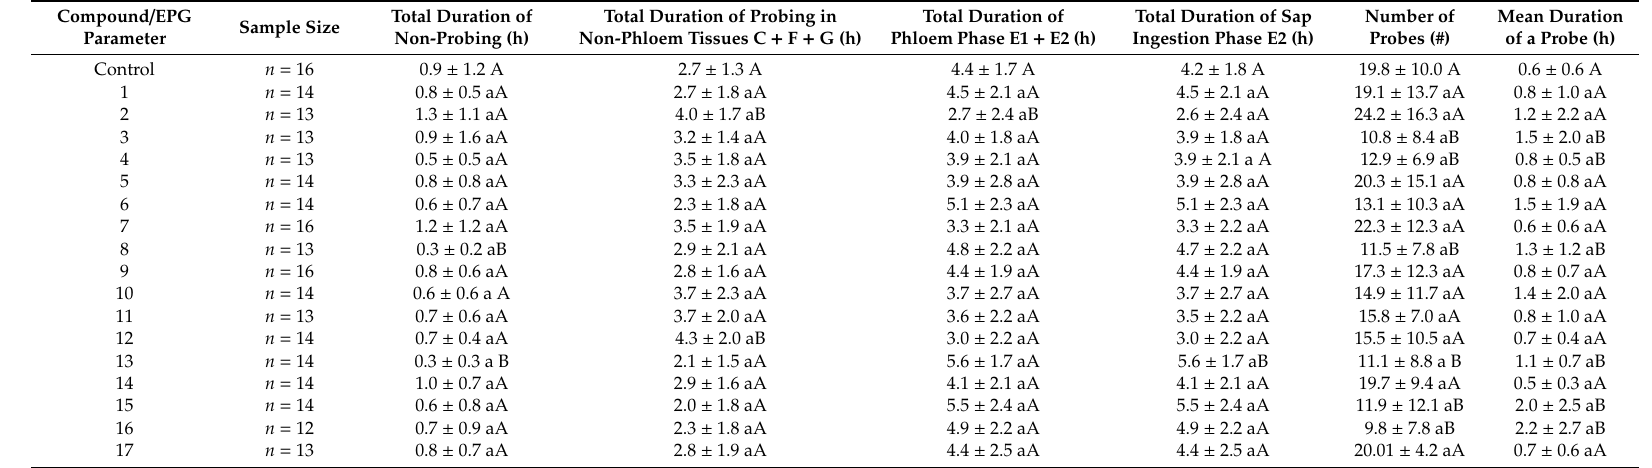
Table 1. General aspects of Myzus persicae probing behavior on naringenin and naringenin derivatives ( 1 – 17 , Figures 1 and 2)-treated plants (means ± SD). The mean and SD values given are a representation of non-Gaussian data, but the statistical analysis was done by non-parametric tests, in which all individual data were included; n —number of replications; C—pathway; E1—phloem salivation; E2—phloem sap ingestion; F—derailed stylet movements; G—xylem sap ingestion. Di ff erent small letters in columns show significant di ff erences in the values of specific parameters among aphids on plants treated with individual naringenin derivatives (Kruskal–Wallis test, p < 0.05); di ff erent capital letters show significant di ff erences in the values of specific parameters between aphids on plants treated with individual compounds and control (Mann–Whitney U-test, p <